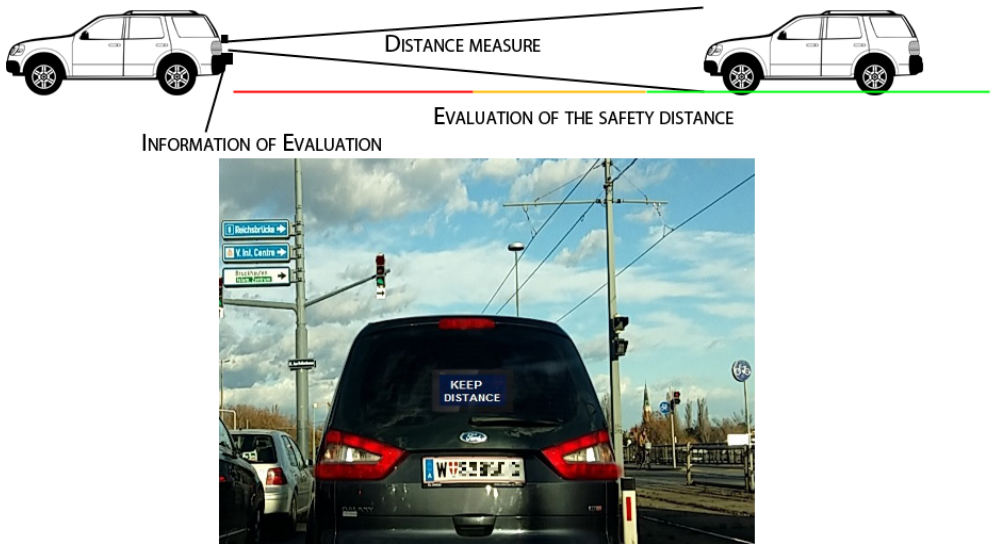
Figure 1. Tailigator Advanced Driver Assistant Systems (ADAS) in which visual data related to the safety distance is provided to the rear vehicle in real-time